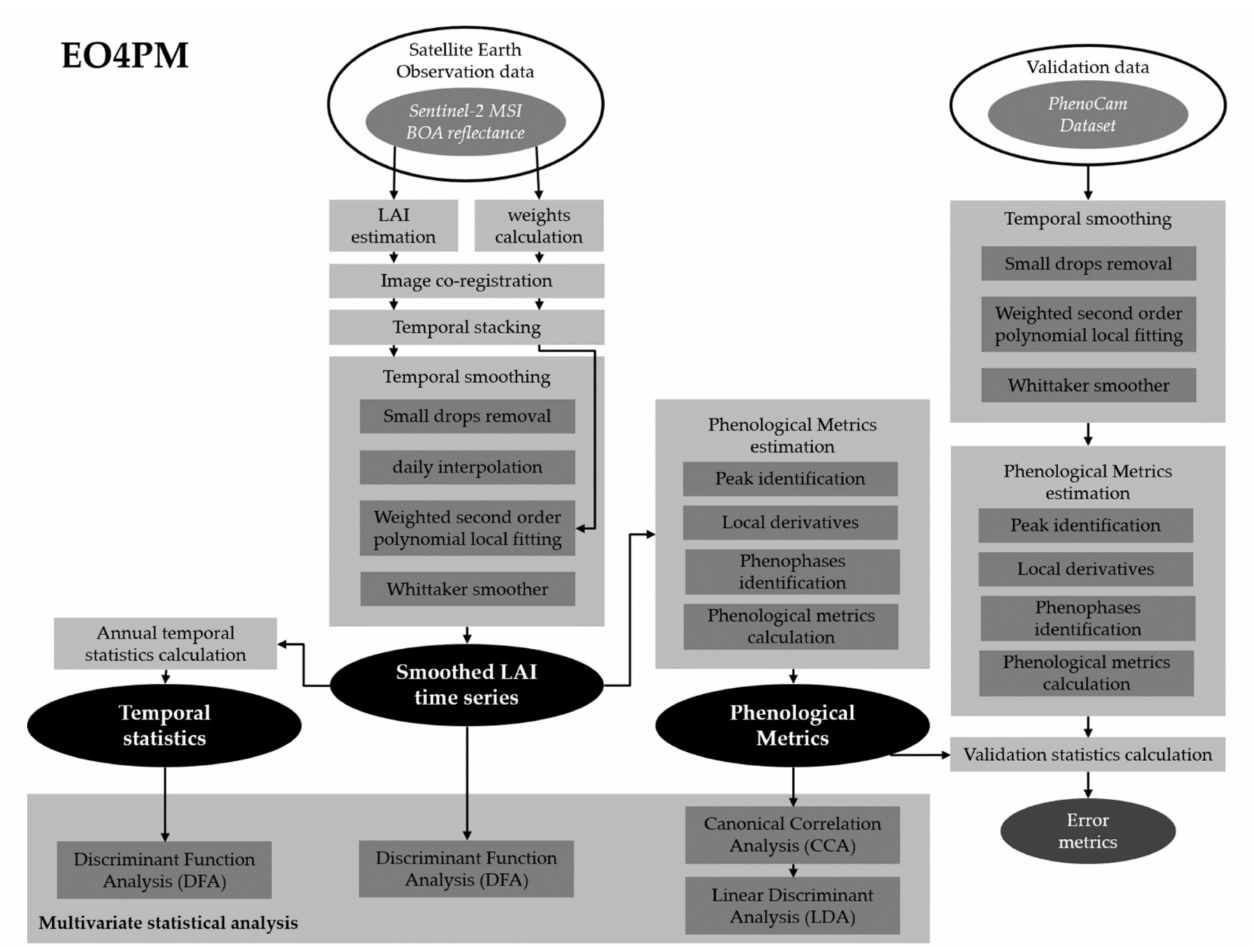
Figure 2. Flowchart of the main phases of the procedure to generate phenological metrics datasets and to perform multivariate statistical analysis. White ellipse refers to input data, grey boxes refer to data processing phases, black ellipses refer to output